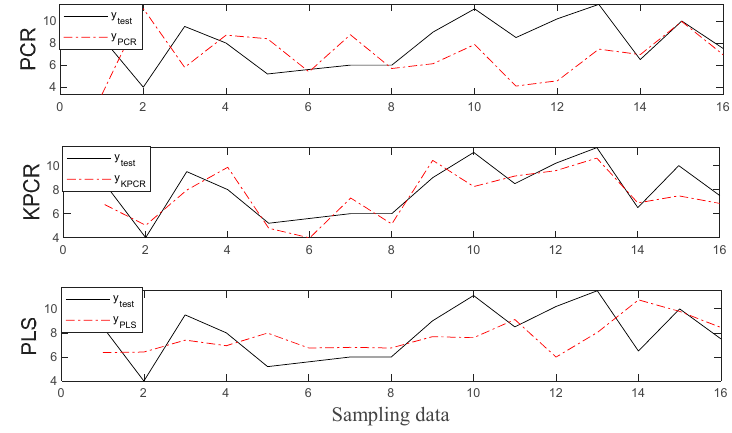
Figure 4. The regression results for the root length.